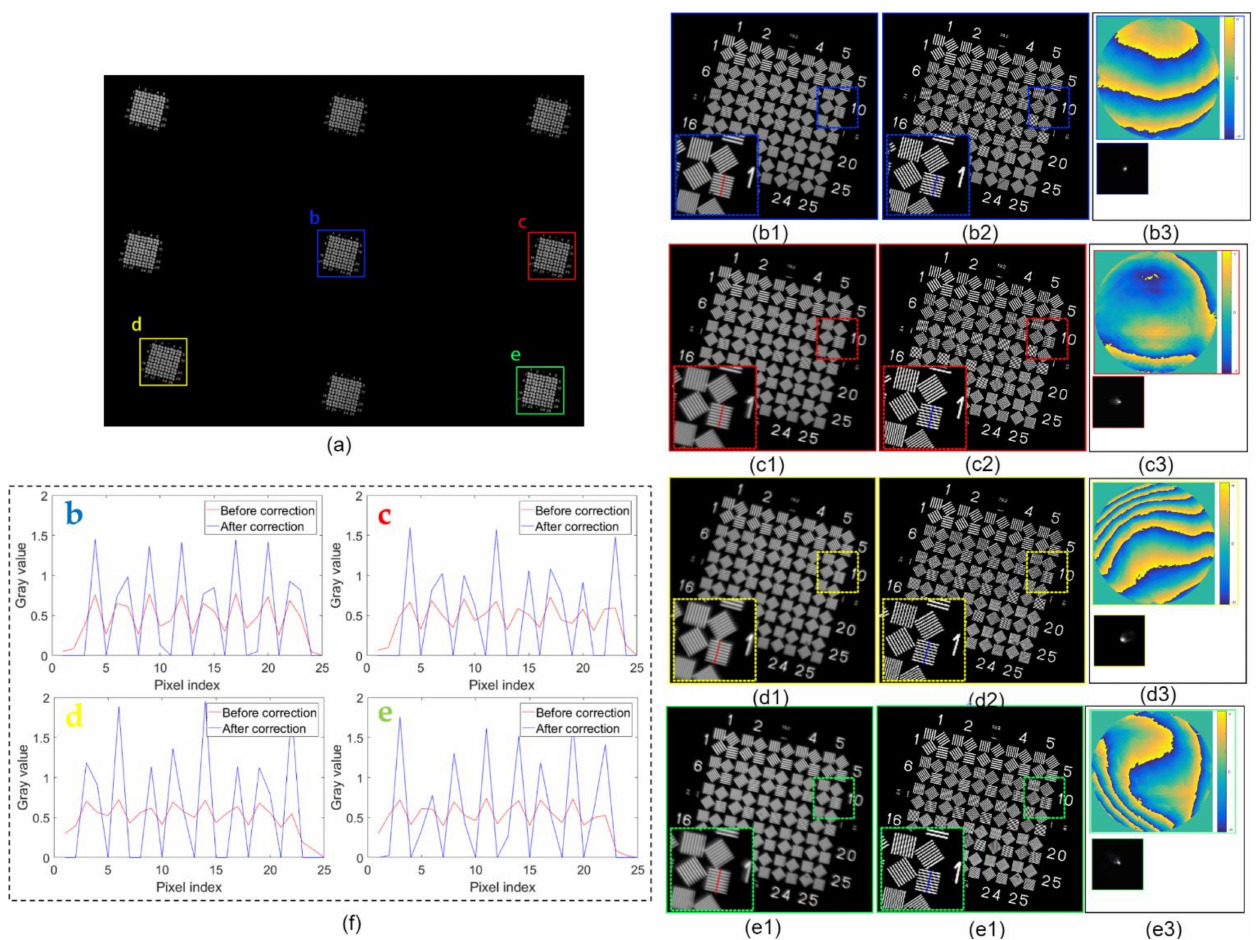
Figure 8. Spatially varying aberration calibration and correction result on a WT1005-62 resolution test target. ( a ) Full FOV image. The pupil function and PSF of each small region denoted by ( b1 – e1 ) varied spatially, as shown in ( b3 – e3 ). The deconvolution results ( b2 – e2 ) show that the spatially varying aberrations were adequately corrected after processing. The inset frame enlarges part of the sample to indicate the enhanced resolution. ( f ) Line profiles through the line pairs in ( b1 – e1 ) ( b2 – e2 ) to highlight the aberration correction